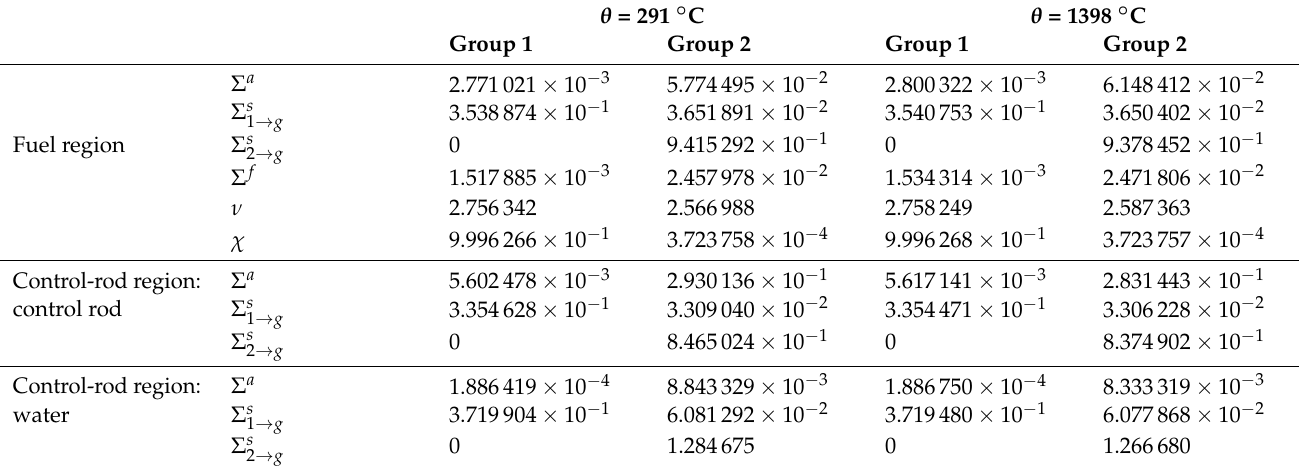
Table 1. Sets of macroscopic cross-sections calculated with WIMS [43] used in the high-fidelity